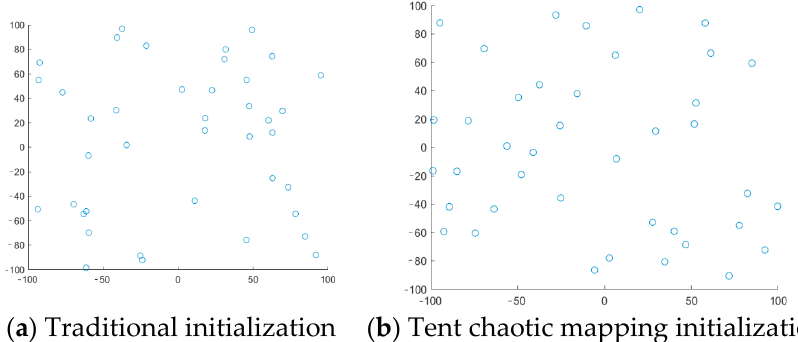
Figure 2. Two initialization methods’ two-dimensional comparison chart.